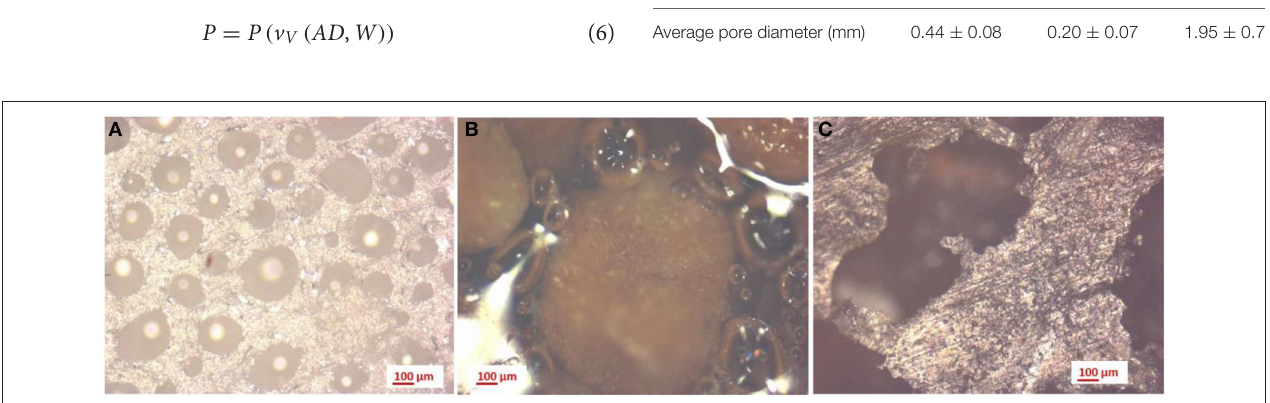
Frontiers in Materials |